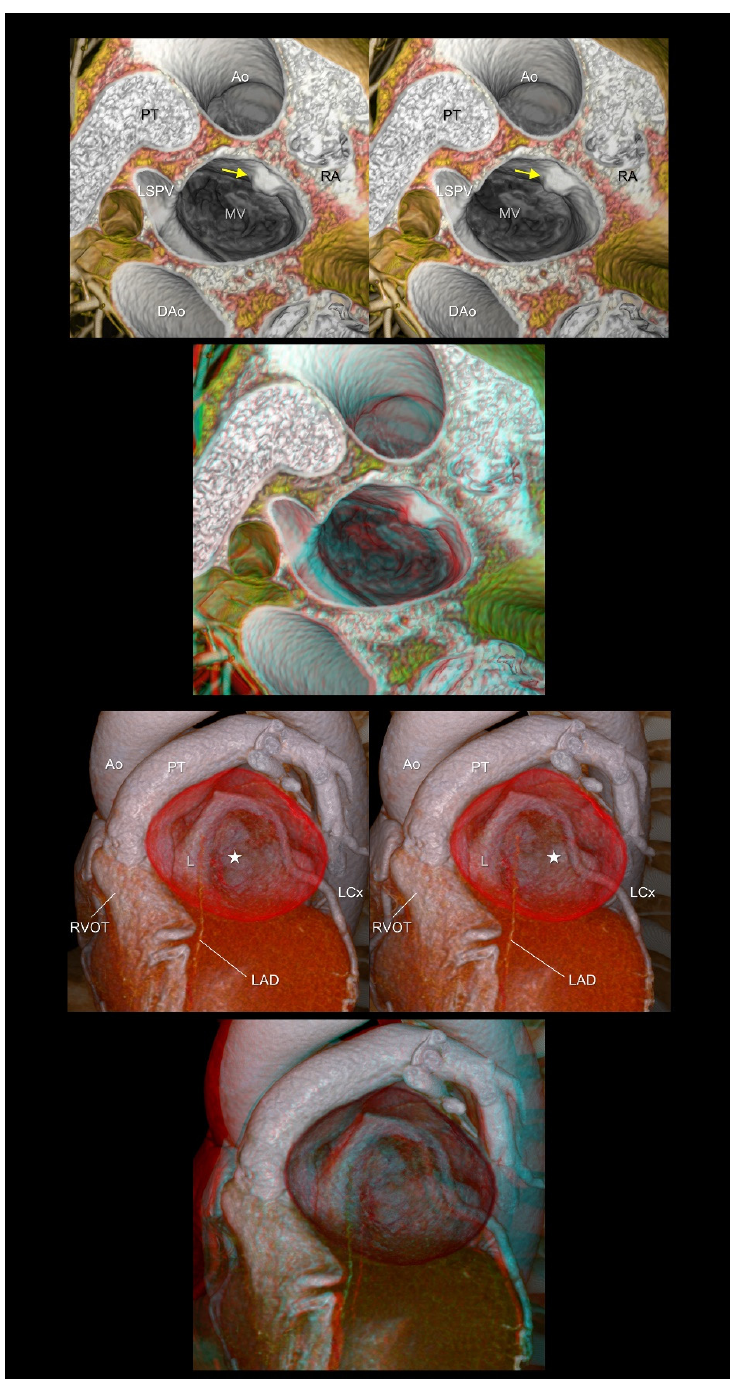
Figure 9. The upper panels show left atrial myxoma (yellow arrows). The lower panels show a giant coronary arterial aneurysm in the proximal left descending artery (white stars). The aneurysm is compressing or displacing the surrounding cardiac structures, including the right ventricular outflow tract, pulmonary root and trunk, left atrial appendage, and left circumflex artery. The first and second panels are aligned for cross ‐ eyed viewing. The third panel is the anaglyph. To see the ana ‐ glyph, anaglyphic glasses (red/cyan) are required. Ao, ascending aorta; DAo, descending aorta; L, left coronary aortic sinus; LAD, left anterior descending artery; LCx, left circumflex artery; LSPV, left superior pulmonary vein; MV, mitral valve; PT, pulmonary trunk; RA, right atrium; RVOT, right ventricular outflow tract.